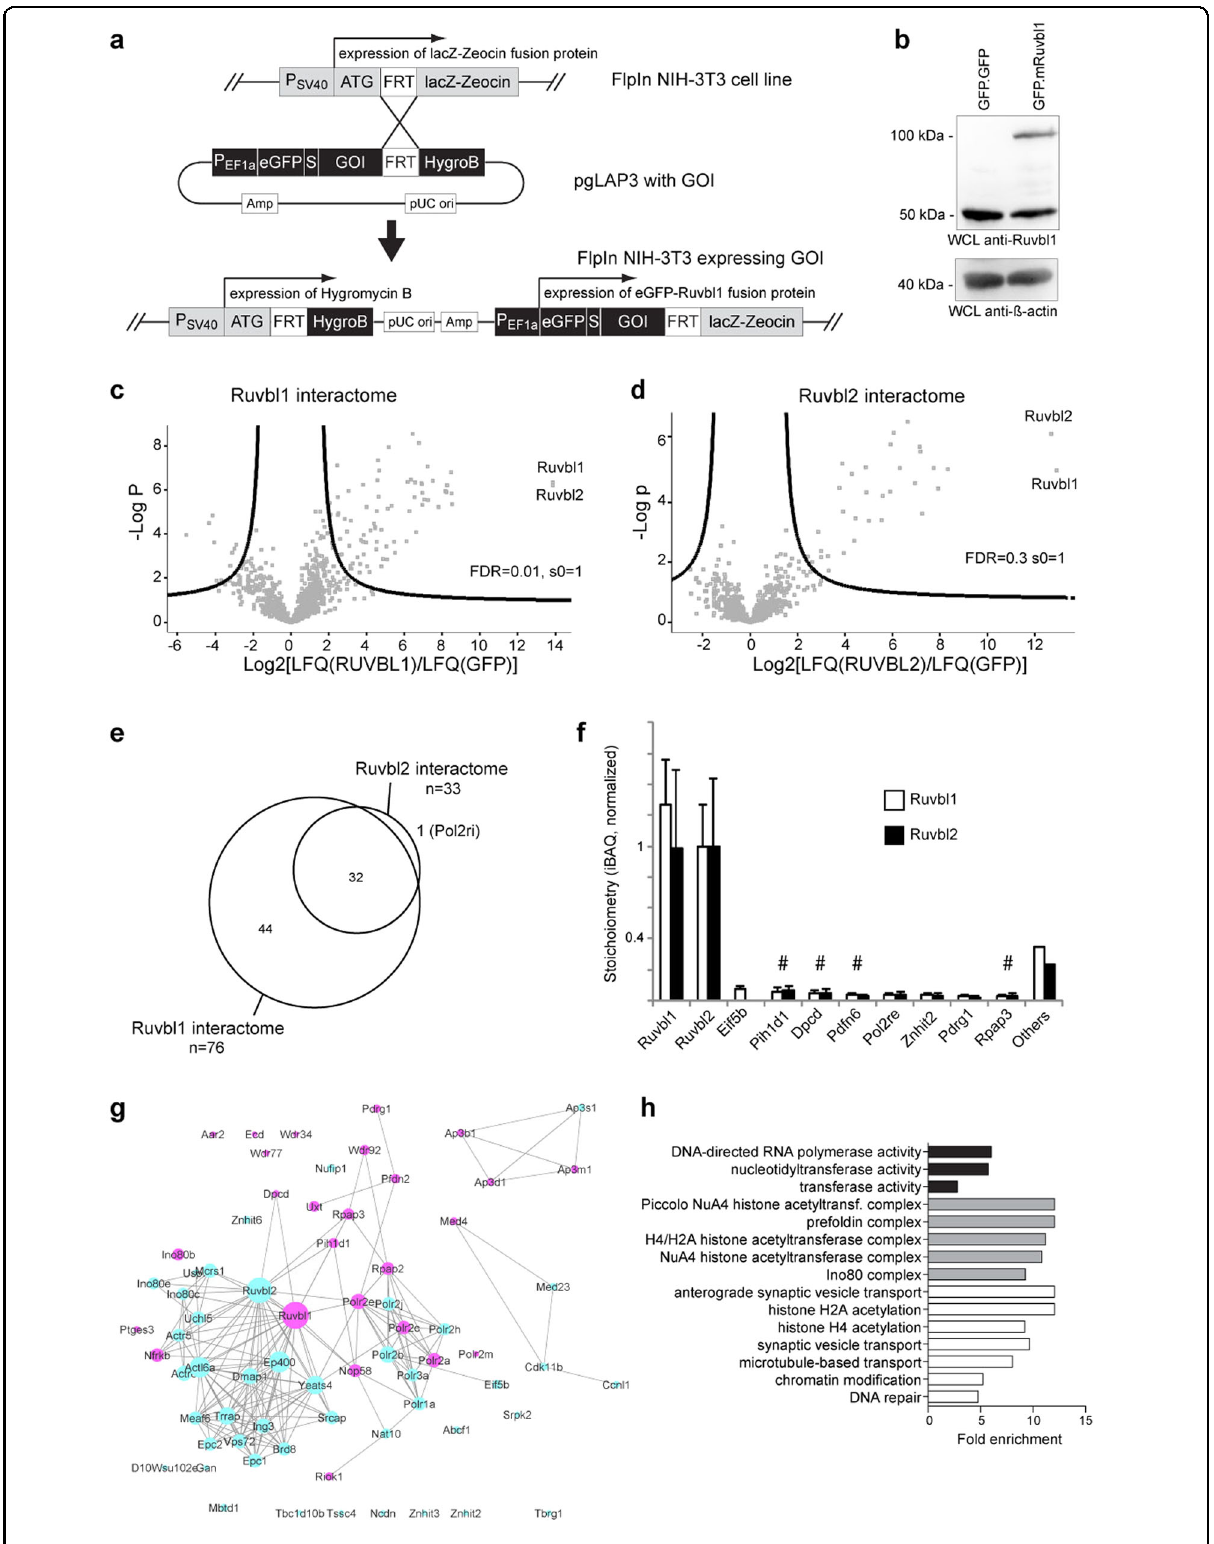
Fig. 4 (See legend on next